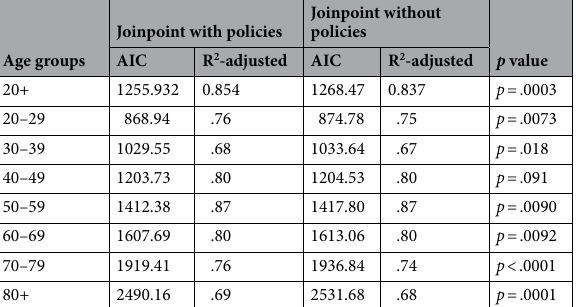
Table 2. Comparison of joinpoint model with and without alcohol policies with Likelihood ratio test of significance (two-tailed, p value), by age group. Lower AIC indicates a better model fit.